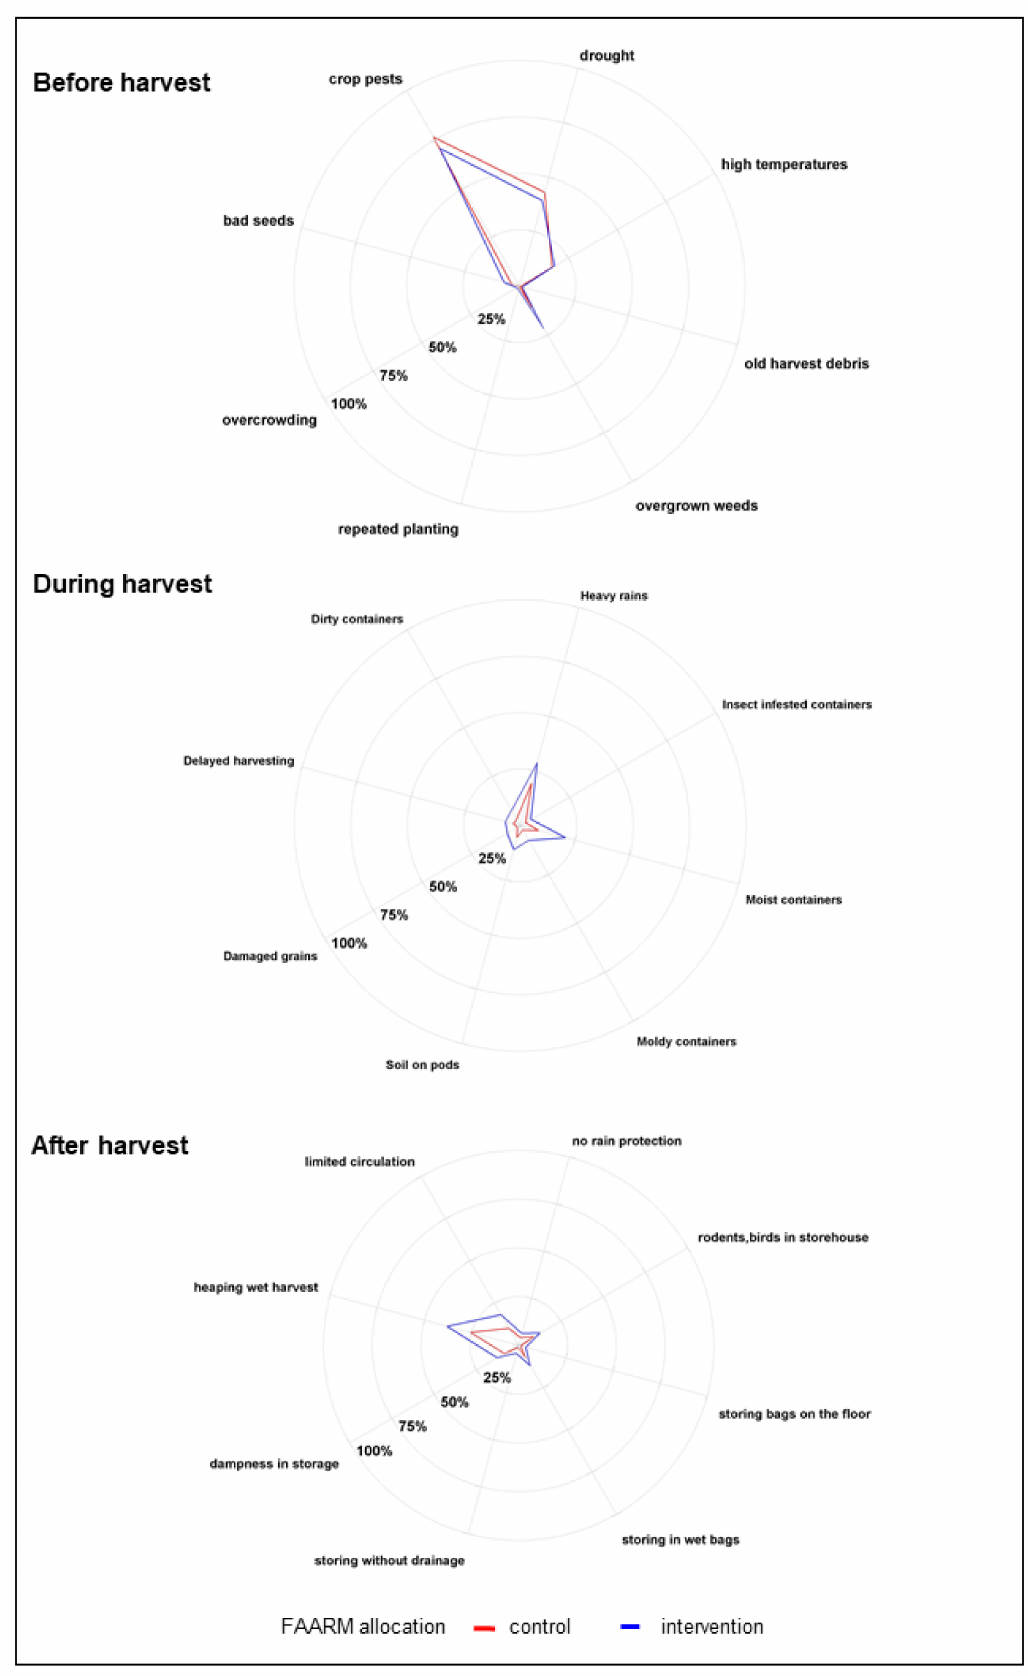
Figure 2. Conditions for mold proliferation ( n =